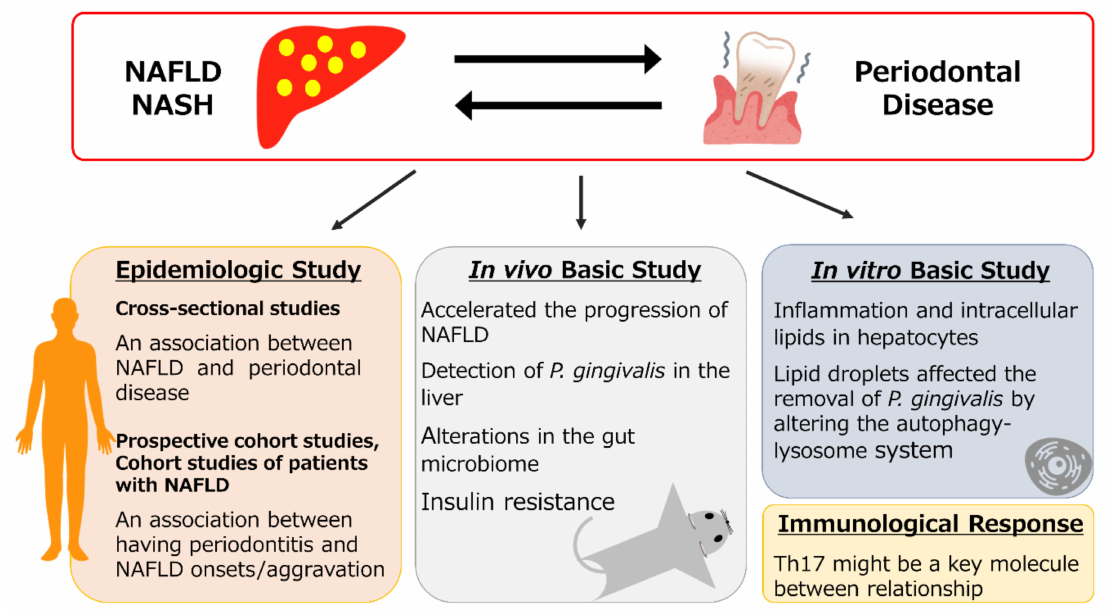
Figure 1. The summary of this review. Periodontal disease has an association with